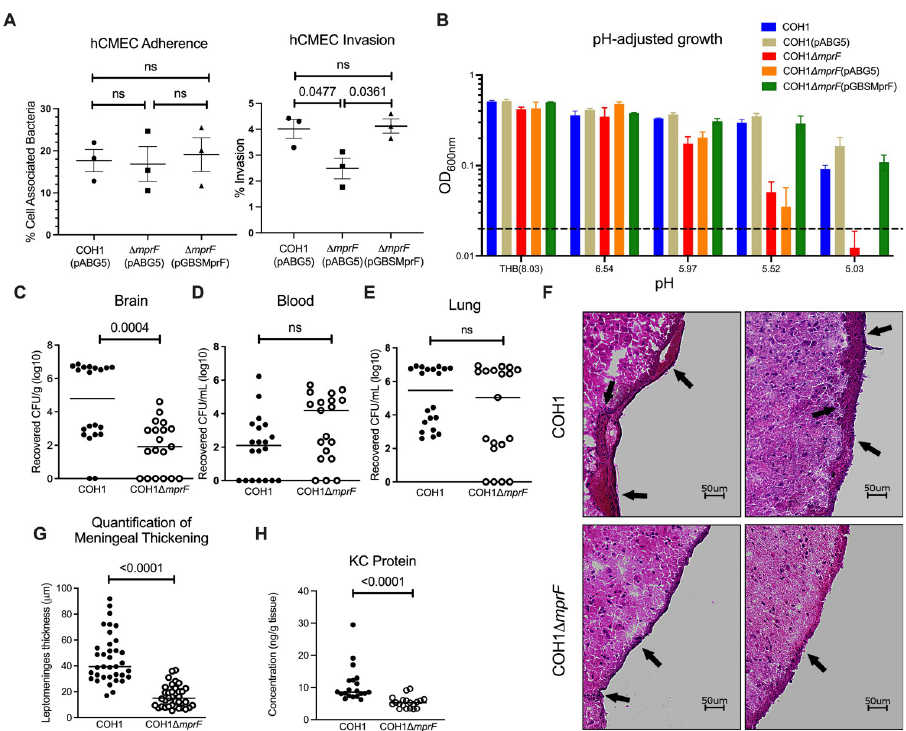
Fig 2. Contribution of lysine lipids to meningitis pathogenesis. (A) In vitro assays for adherence and invasion of hCMEC cells indicates mprF contributes to invasion but not adherence to brain endothelium (the mean of each biological replicate is displayed, comprised of 4 replicate wells per biological replicate, mean and SEM). (B) pH- adjusted medium growth indicates Δ mprF cannot survive in low pH conditions, mean and SD. Groups of CD-1 mice were injected intravenously with COH1 WT or COH1 Δ mprF strains and bacterial counts were assessed in the (C) brain, (D) blood, and (E) lung after 72 hours. Representative data from 2 independent experiments are shown (WT, n = 20; Δ mprF , n = 19). (F) Hematoxylin–eosin–stained brain sections from representative mice infected with WT (top) or Δ mprF mutant (bottom); arrows indicate meningeal thickening and leukocyte infiltration. (G) Quantification of meningeal thickening using ImageJ. (H) KC chemokine production measured by ELISA. Panels C, D, E, G, and H median indicated. Statistical analyses performed using GraphPad Prism: (A) One-way ANOVA with Tukey’s multiple comparisons test; (C, D, G) unpaired two-tailed t test; (E, H) Mann–Whitney U test; p -values indicated; ns, no significance ( p -value > 0.05). The numerical data underlying the graphs shown in this figure are provided in S1 Data. WT,